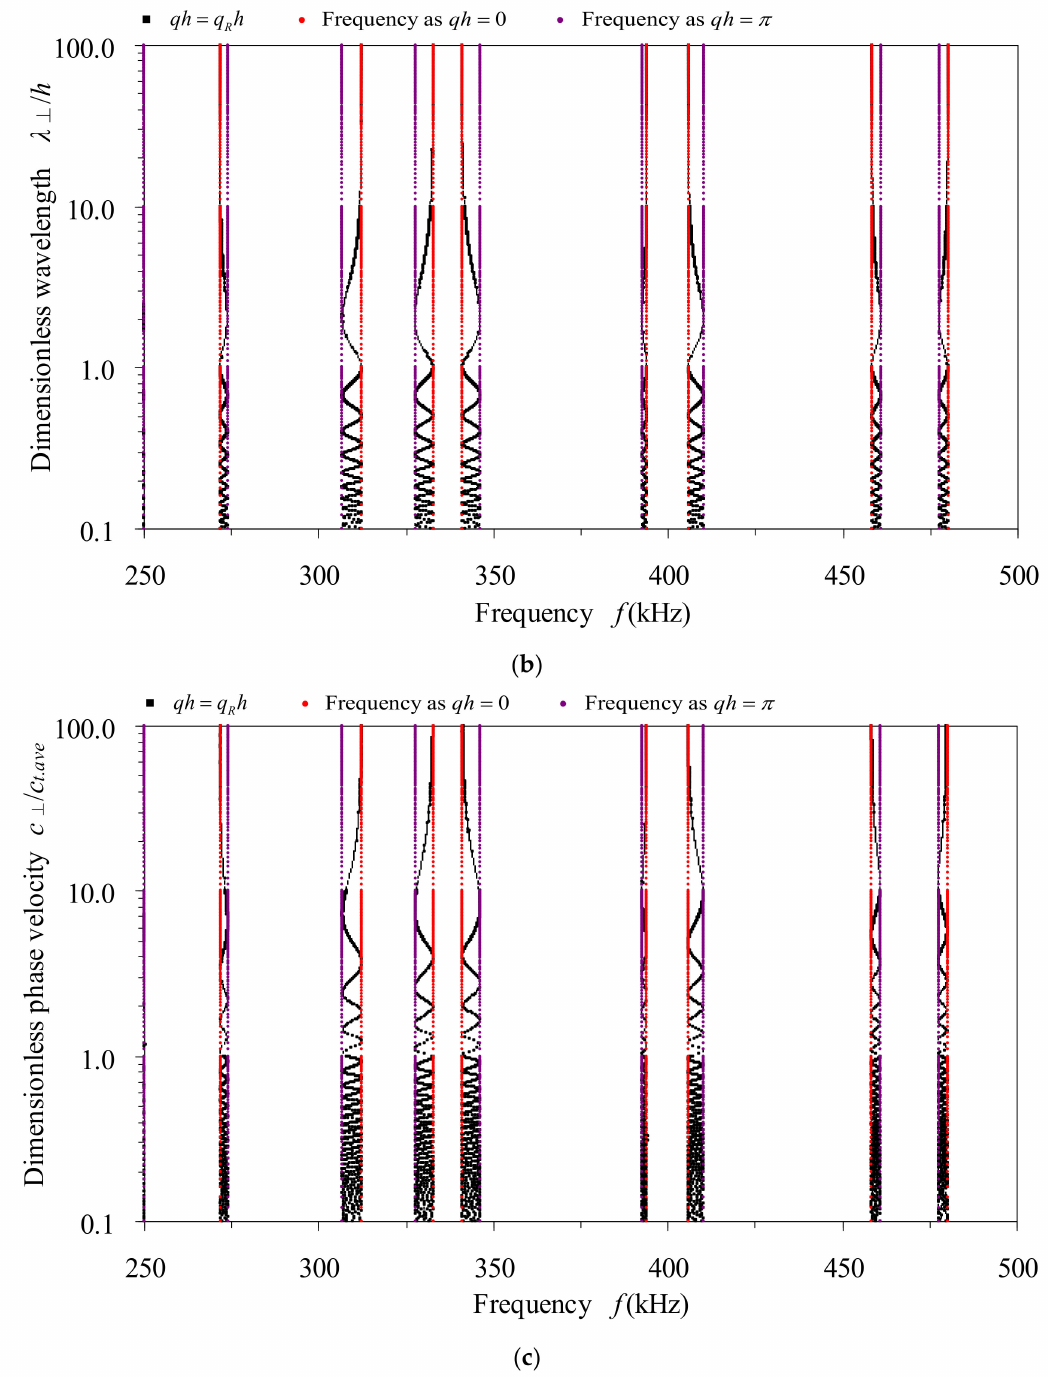
Figure 5. The frequency–related comprehensive dispersion curves in high frequency range of Floquet in–plane waves propagating along the direction perpendicular to layering: ( a ) the frequency–wavenumber spectra, ( b ) the frequency–wavelength spectra, and ( c ) the frequency–phase velocity